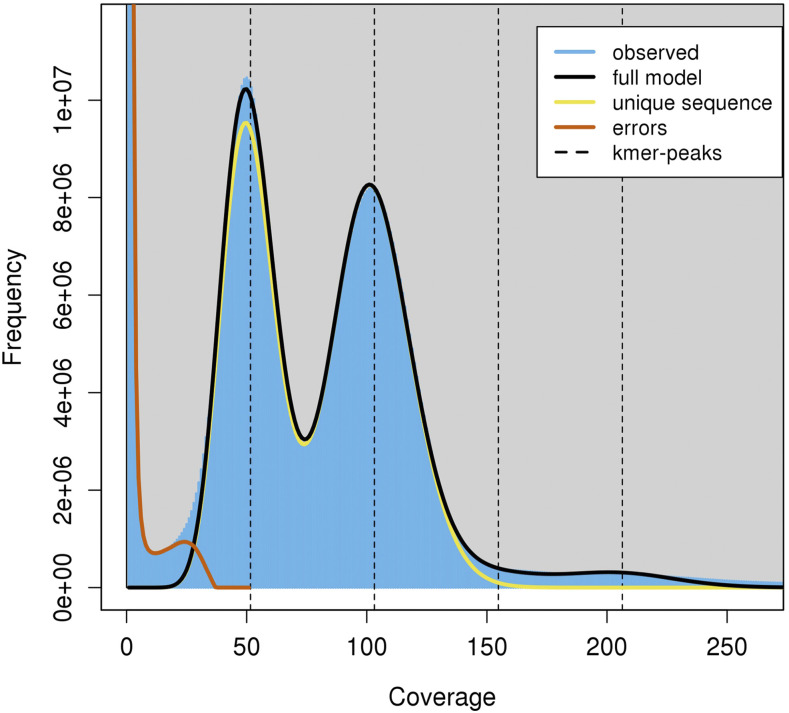
The 25-mer distribution for estimation of genome heterozygosity and size. Peaks at approximately 50, 100 and 200 represent heterozygous, homozygous and repeated k-mers respectively.